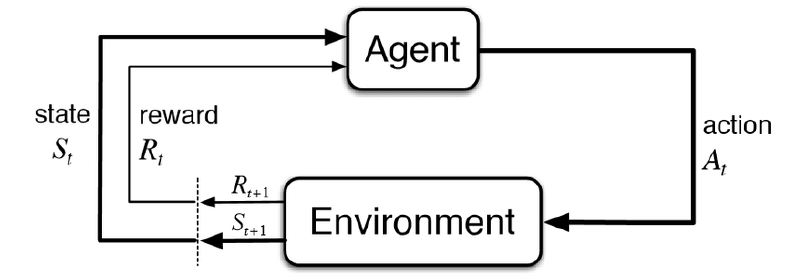
Figure 1. The reinforcement learning